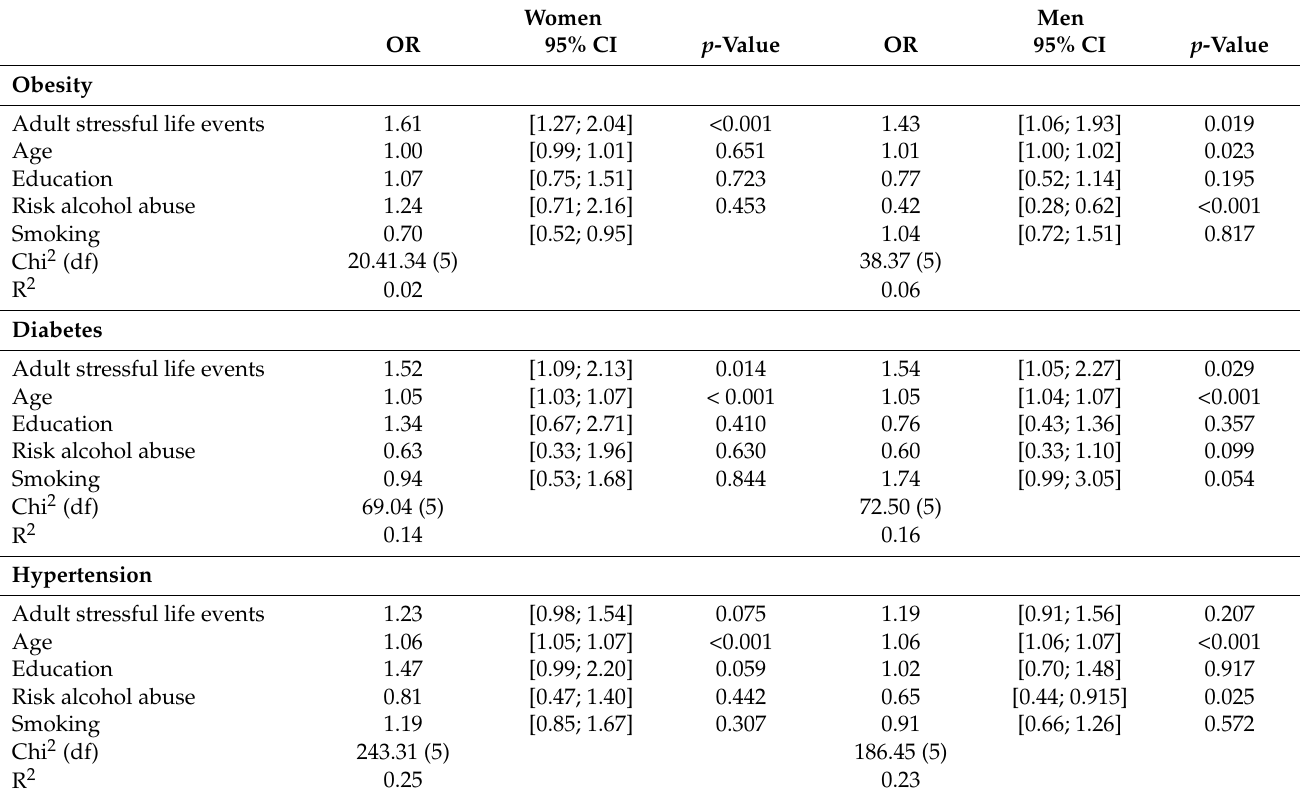
Figure 1. Cardiovascular problems and number of adult stressful life events. Analyzed via Chi²-Tests. Table 2. Predictors of cardiovascular risk factors and myocardial infarction. Stratified for gender, analyzed via logistic regression analysis.